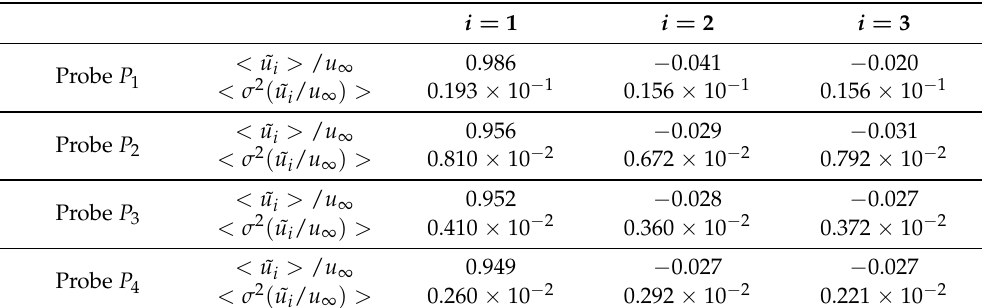
Table 4. Non dimensional mean value < ˜ u i > / u ∞ and variance < σ 2 ( ˜ u i / u ∞ ) > of velocity components u i ( i = 1,2,3 ) from time series at probes P j ( j = 1 to 4) and t > T conv .